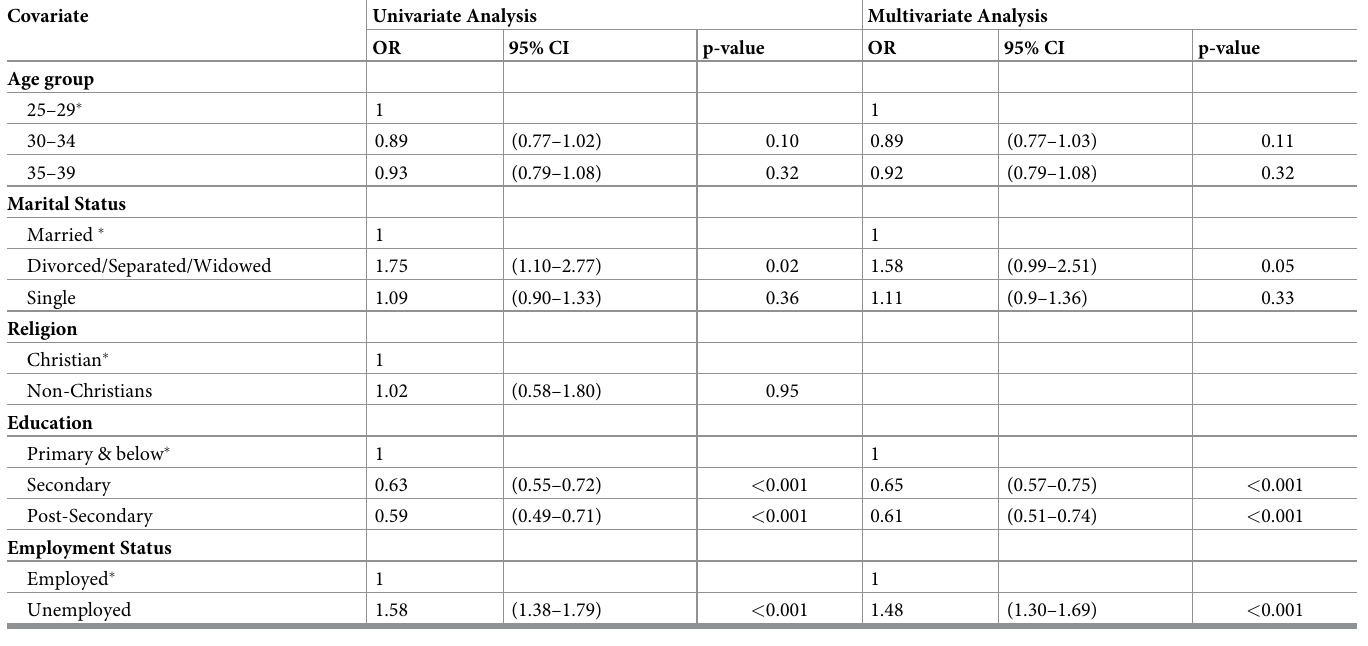
Table 3. Demographic predictors for consenting to genital examination to verify circumcision status (n = 5,639).